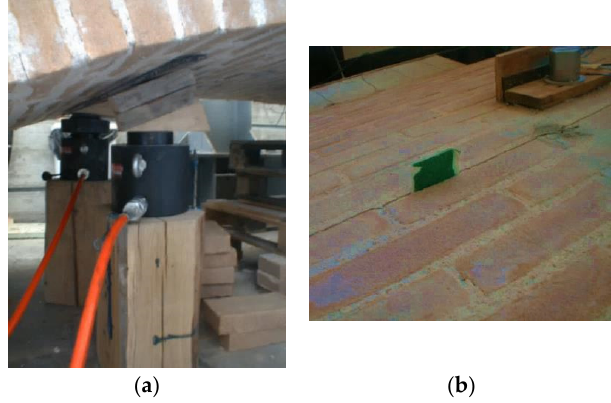
Figure 9. ( a ) Application of hydraulic cylinders to promote damage; ( b ) Hinge formation.